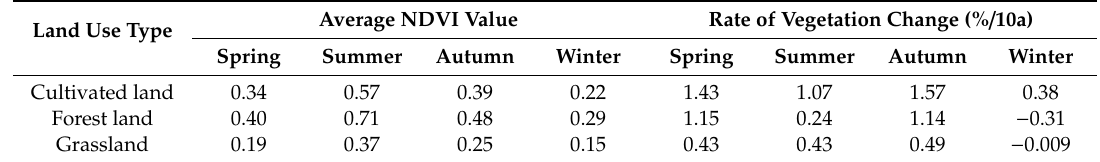
Table 2. The average NDVI of each land use types and its variation on seasonal scale from 1982–2015. Average NDVI Value Rate of Vegetation Change (% / 10a) Land Use Type